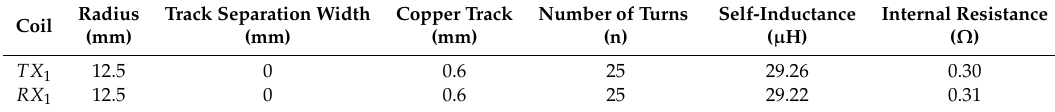
Table 1. Parameters of TX and RX.